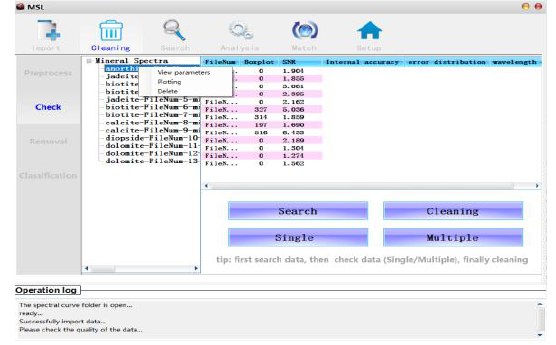
Figure 10. Interface of data cleaning